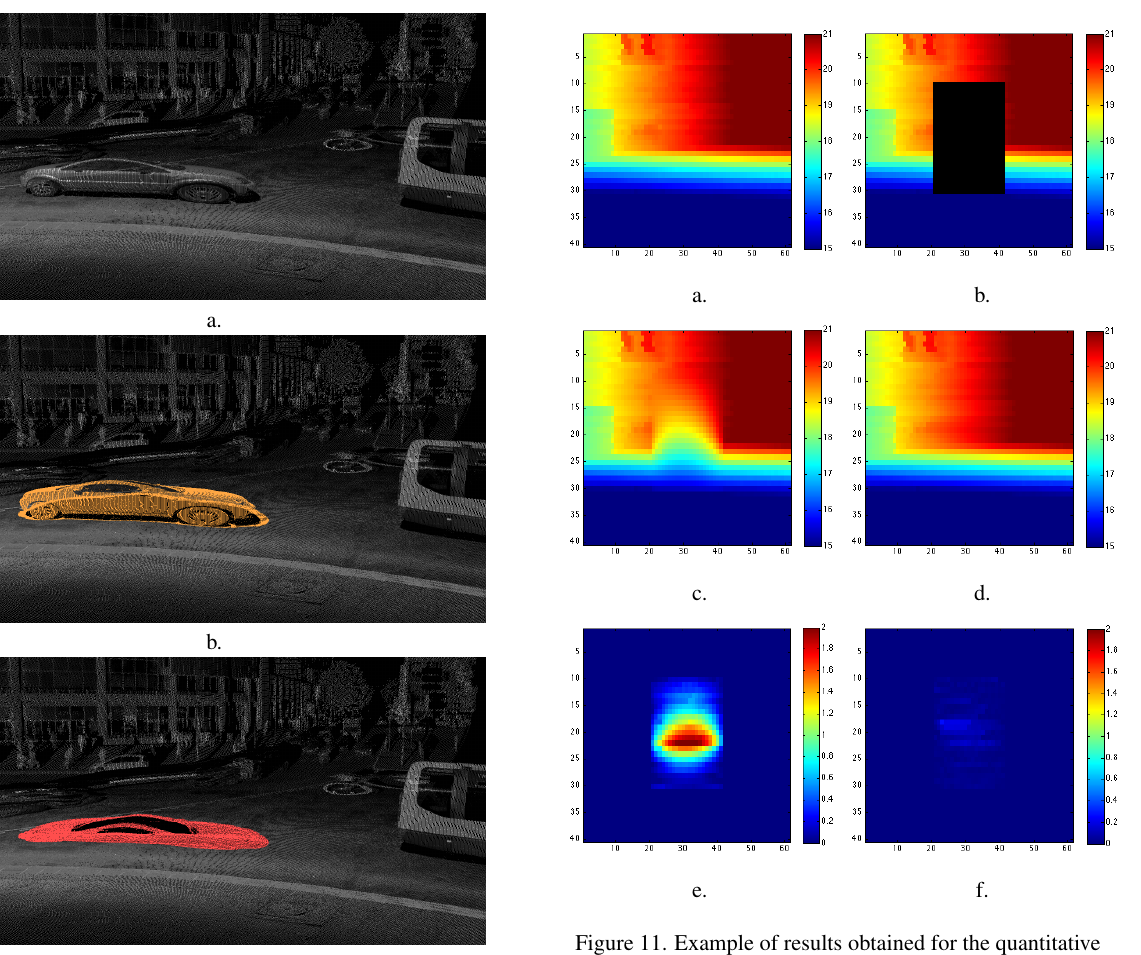
Figure 11. Example of results obtained for the quantitative experiment. (a) is the original point cloud (ground truth), (b) the artificial occlusion in dark, (c) the disocclusion result with the Gaussian diffusion, (d) the disocclusion using our method, (e) the Absolute Difference of the ground truth against the Gaussian diffusion, (f) the Absolute Difference of the ground truth against our method. Scales are given in